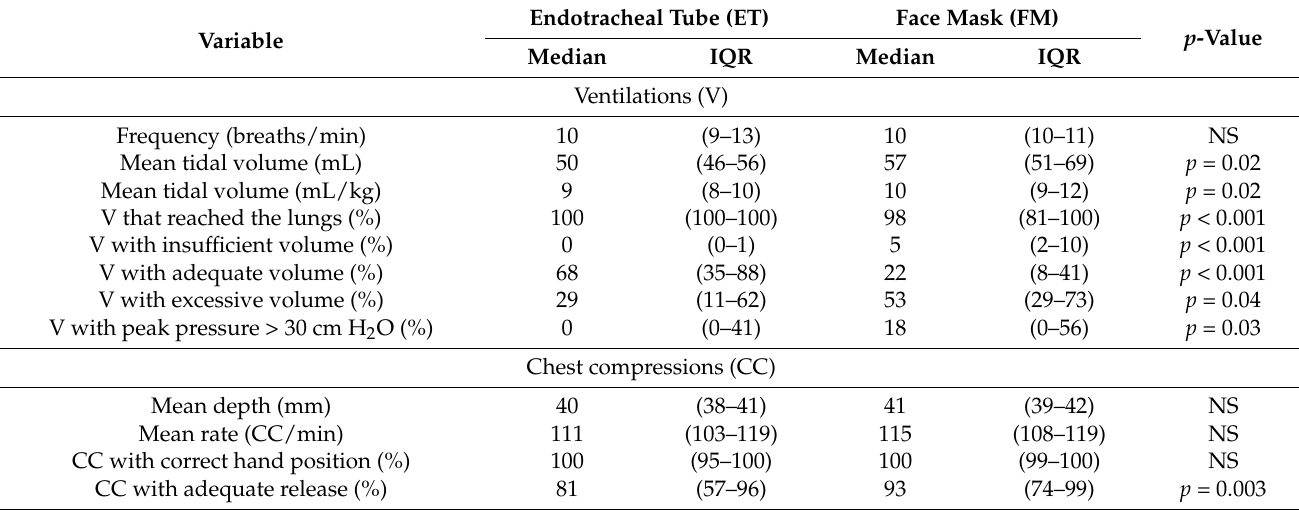
Table 1. Quality of ventilations and chest compressions. Comparison of ET and FM tests.